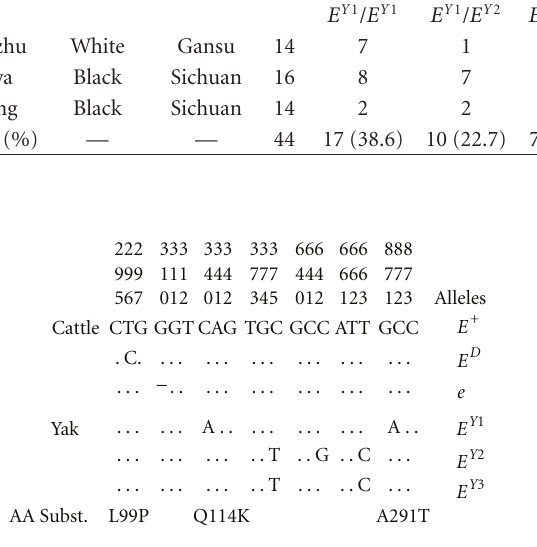
Figure 2: Sequence variations of the three MC1R haplotypes in yaks. Dots ( • ) denote identity with the cattle MC1R allele E + , which was used as a reference sequence (GenBank accession numbers Y13957 and Y19103). Amino acid substitutions (AA Subst.) were listed below the nucleotide information. The three known cattle MC1R alleles were also included to demonstrate the di ff erence between the yak and cattle sequences. Numbering was scored relative to the first codon of the cattle MC1R allele E + .